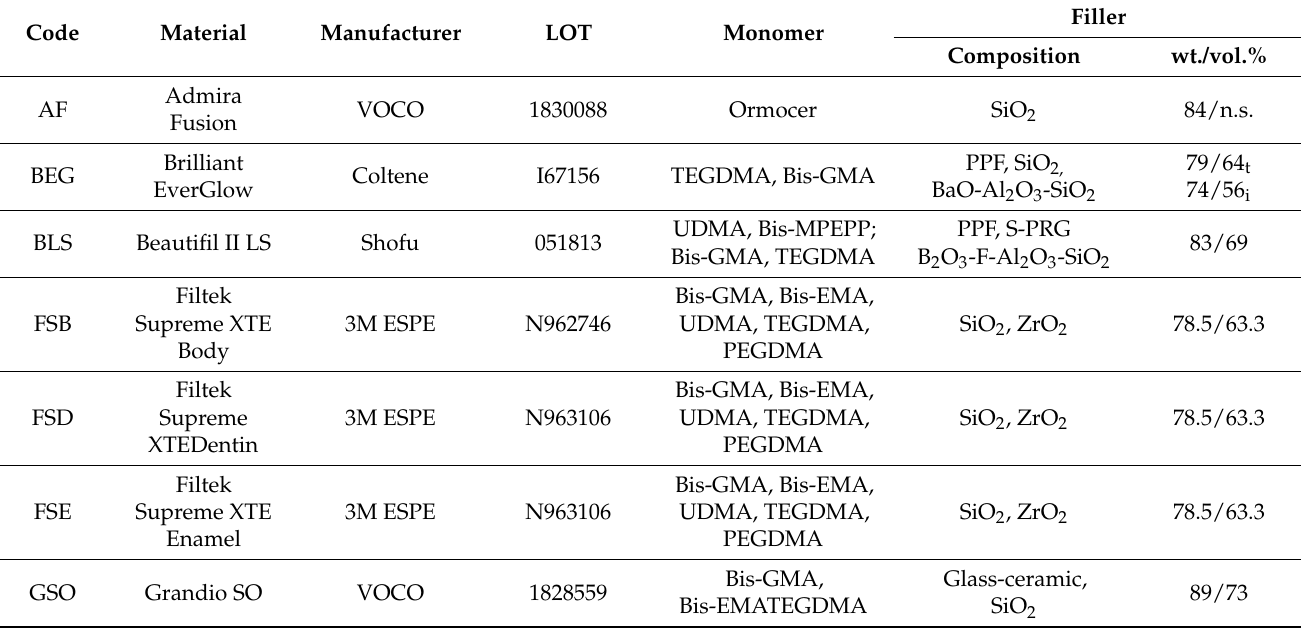
Table 1. Analyzed RBCs: Abbreviation (code), brand, manufacturer, shade, LOT, and composition, as indicated by the